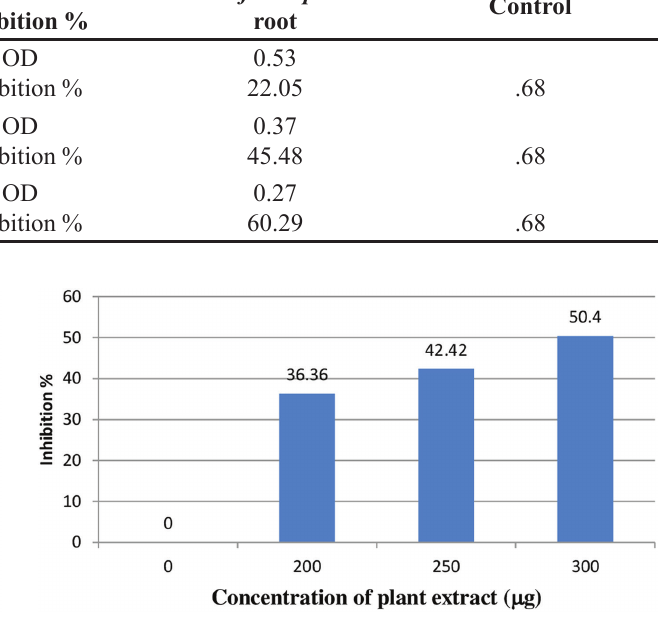
FIGURE 2 - Protease inhibition